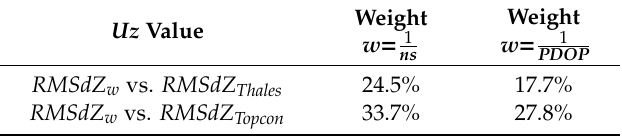
Figure 9. Comparison of the RMS errors along the Z-axis. Table 4. The relation between the RMS error for the tested methodology along the Z-axis.